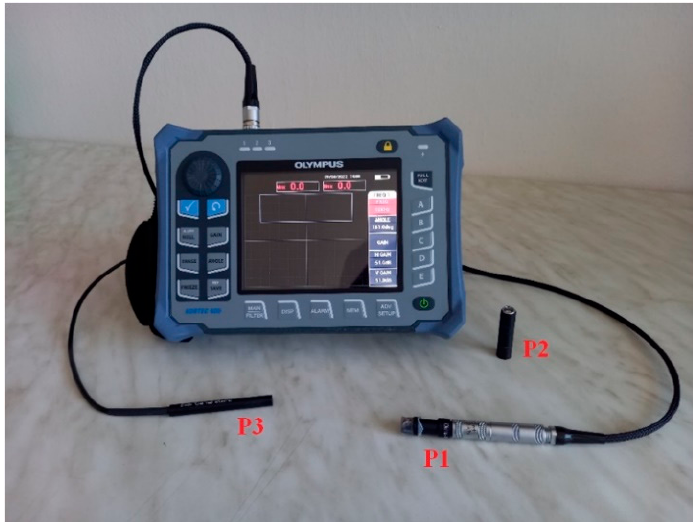
Figure 3. NORTEC 600 eddy current testing device with P1, P2 and P3 probes.